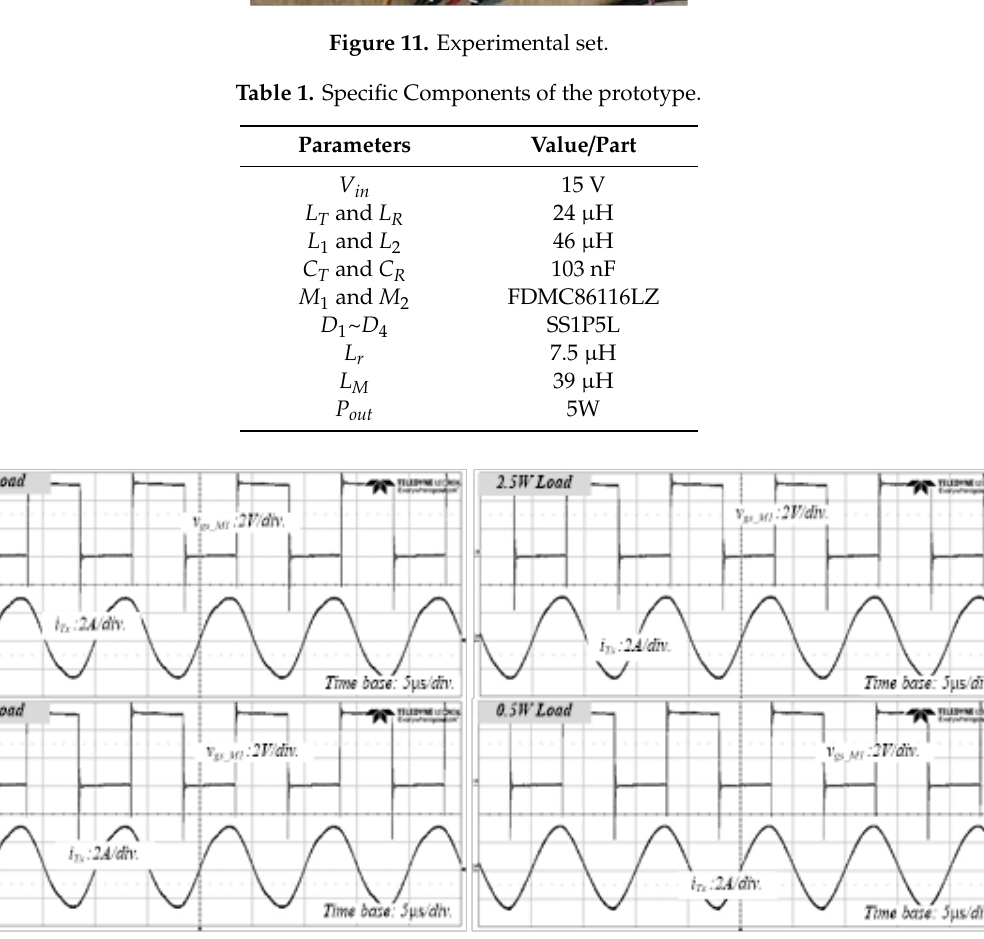
Figure 11. Experimental set.